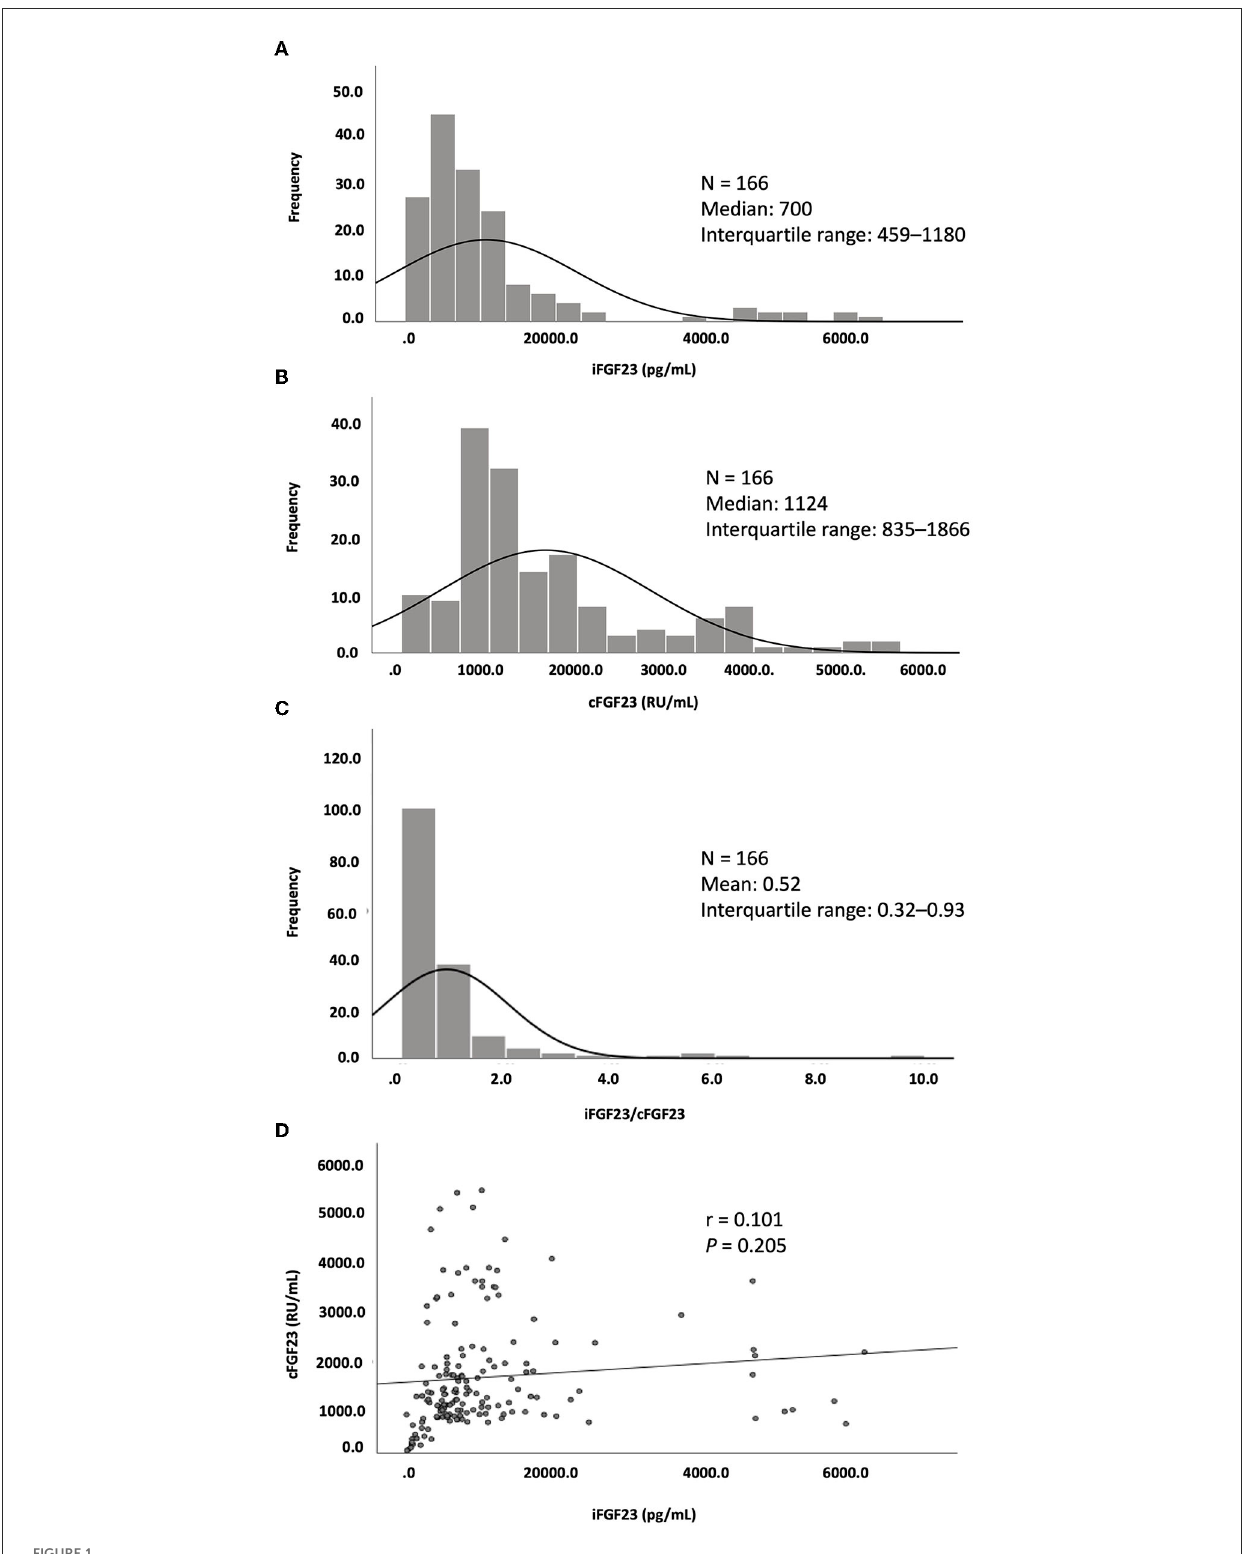
FIGURE1 Distribution of (A) iFGF23, (B) cFGF23, and (C) iFGF23/cFGF23 and (D) the correlation between iFGF23 and